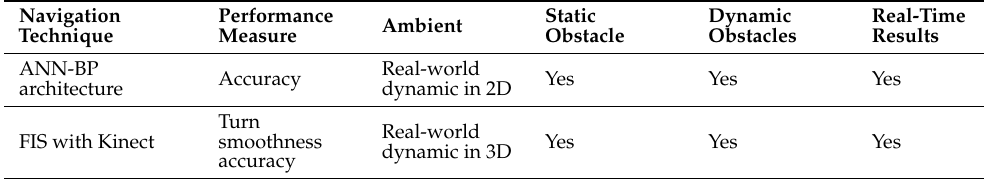
Table 5. Environmental operating conditions.